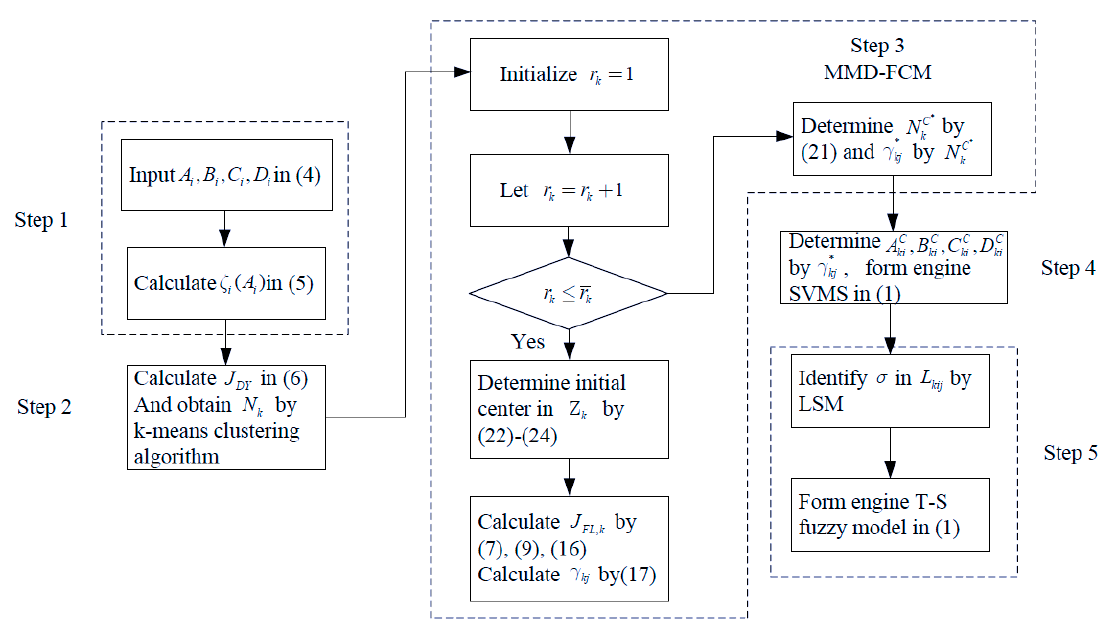
Figure 3. Process of T–S fuzzy modeling for an engine .